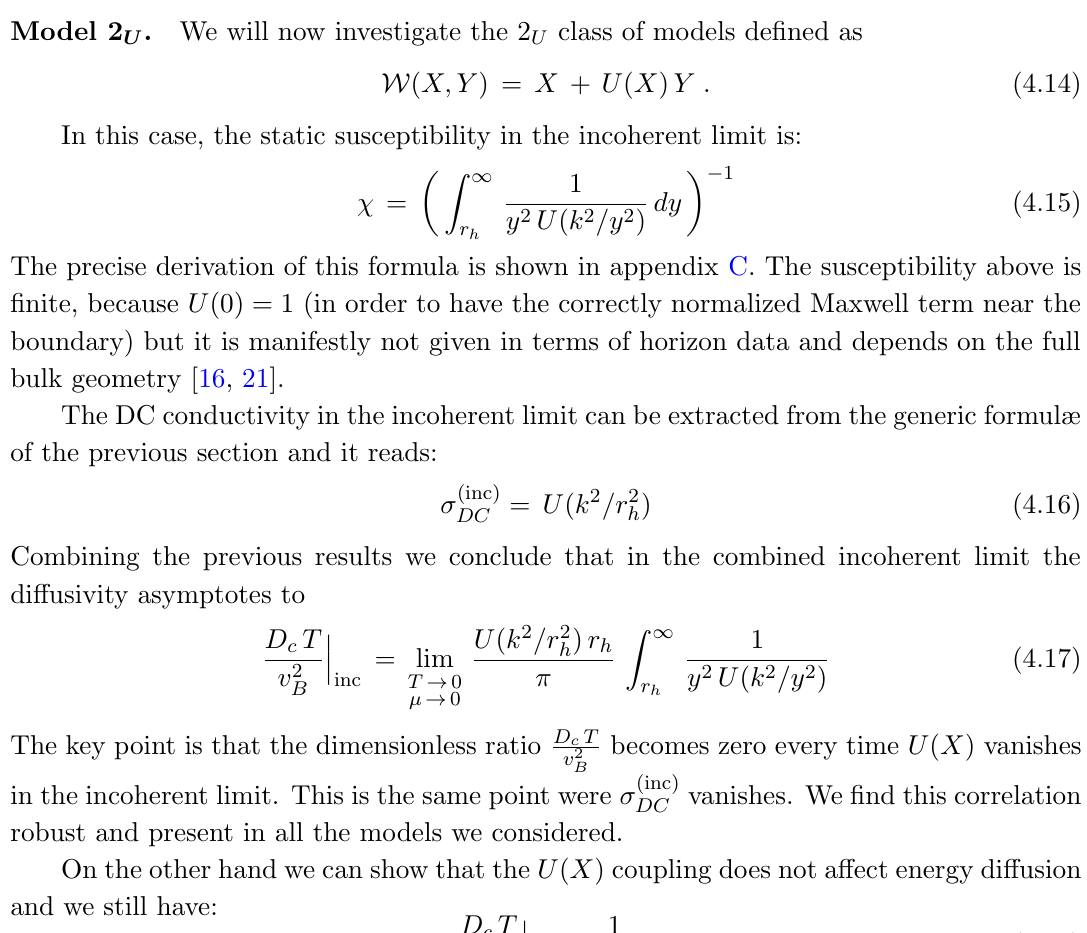
Figure 1 . Physical quantities in the incoherent limit for the speci(cid:12)c model 2 K : U ( X ) = 1 + K X . Left: susceptibility in units of k as a function of K . The dashed red line has been added manually because Mathematica was not able to plot the function in its whole domain . Right: incoherent conductivity as a function of K